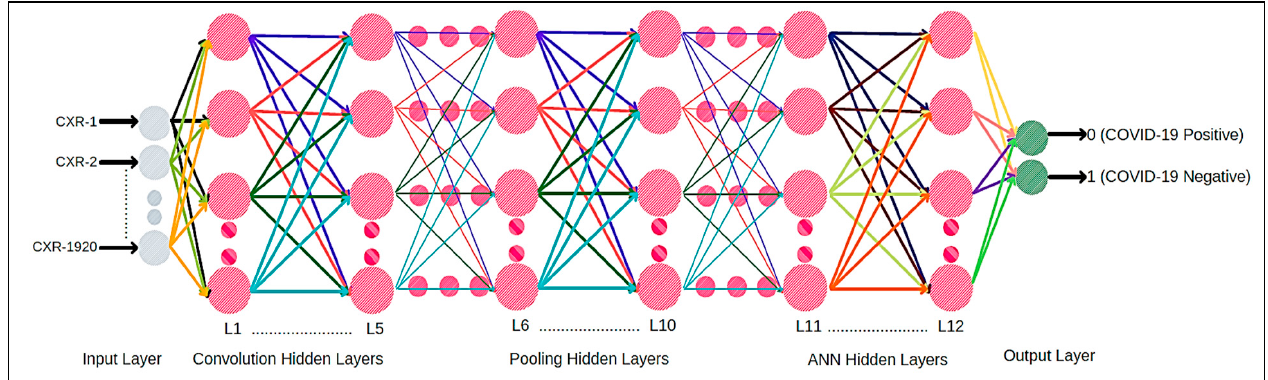
Figure 7. Proposed network model.